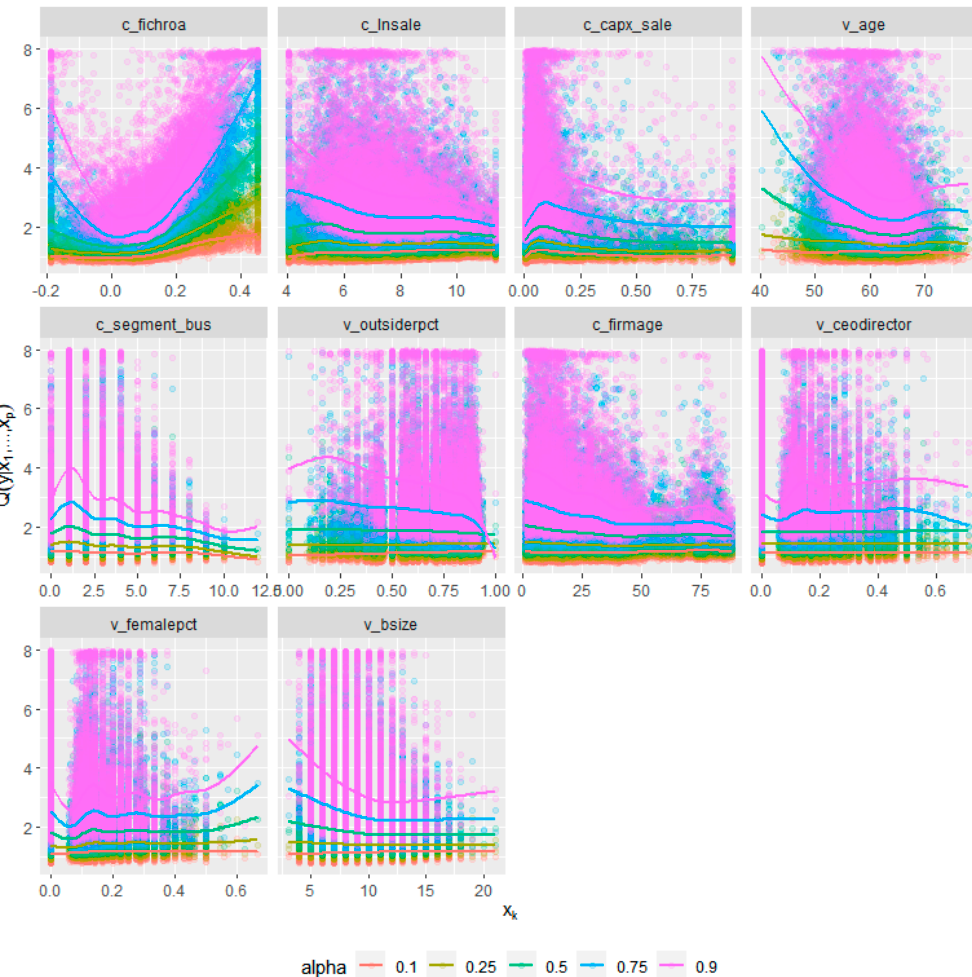
Figure 6. Plots for Nonparametric Copula based Quantile Regressions.